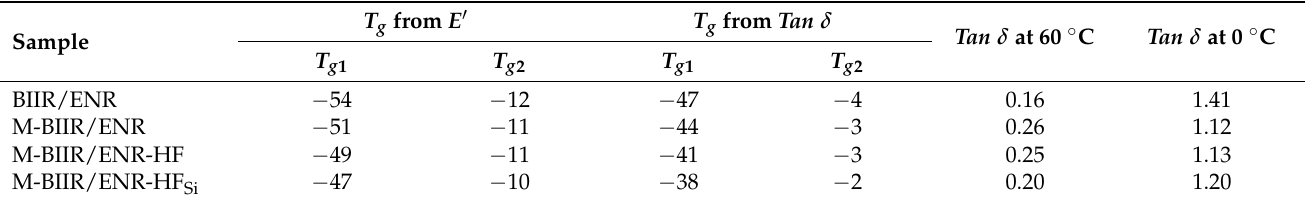
Table 6. Dynamic mechanical of M-BIIR compounds mixed with ENR-CNT/CB composites for the unfilled and filled TESPT silane coupling